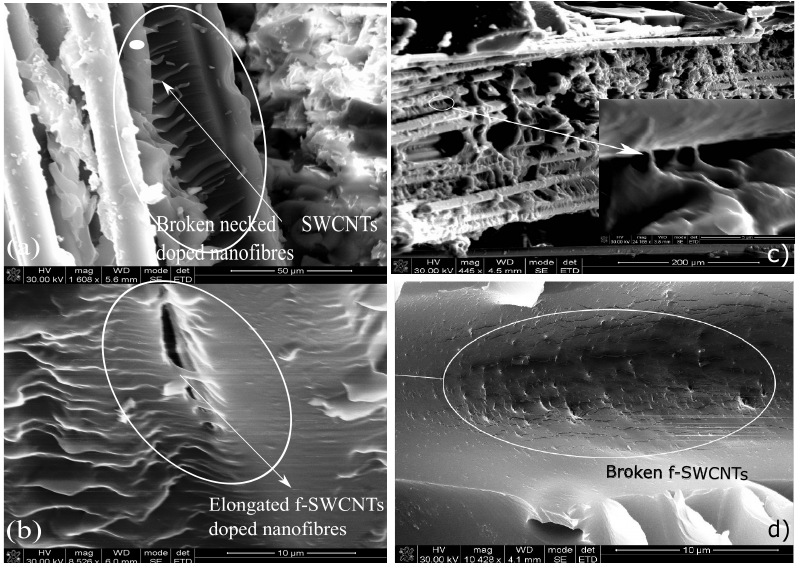
Figure 11. Fracture surfaces of 0.5 wt% nanofibers strengthened hybrid composites ( a ) Elongated f- SWCNTs doped CANFs mats in bridging. ( b ) Bridging of f-SWCNTs doped nanofibers. ( c ) Fractured surfaces of impact tested specimen. ( d ) Pulled and broken head of